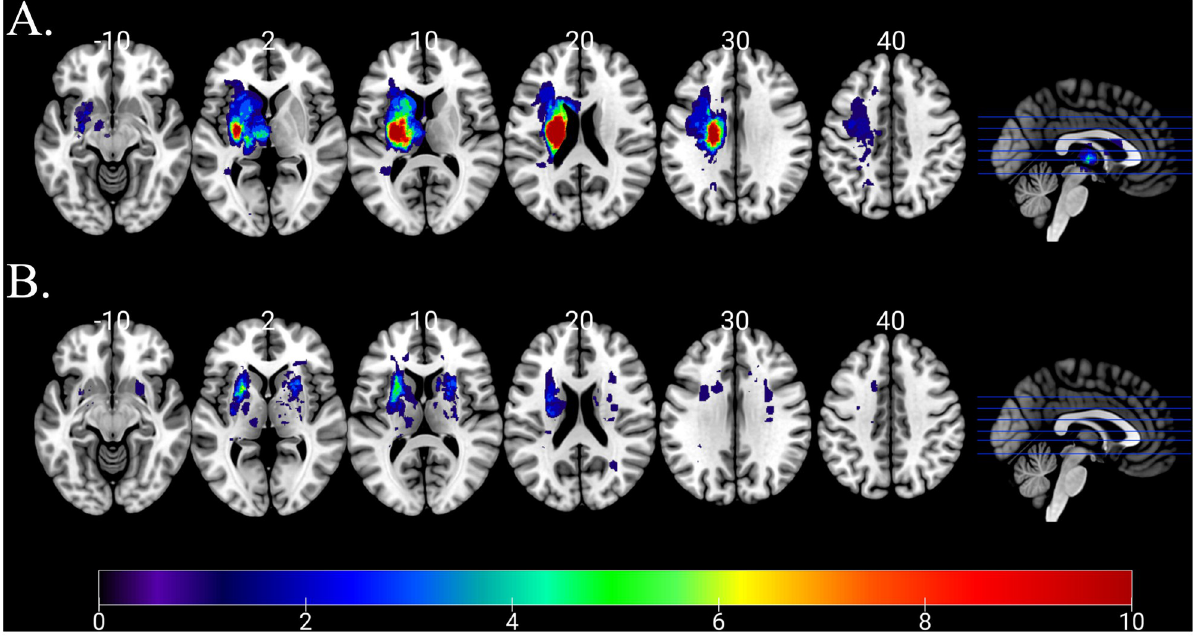
Fig 2. Lesion overlap maps of A) acute stroke lesions and B) prior stroke lesions. The color bar applies to both parts of the figure and indicates the number of patients whose lesions overlap for a given voxel.